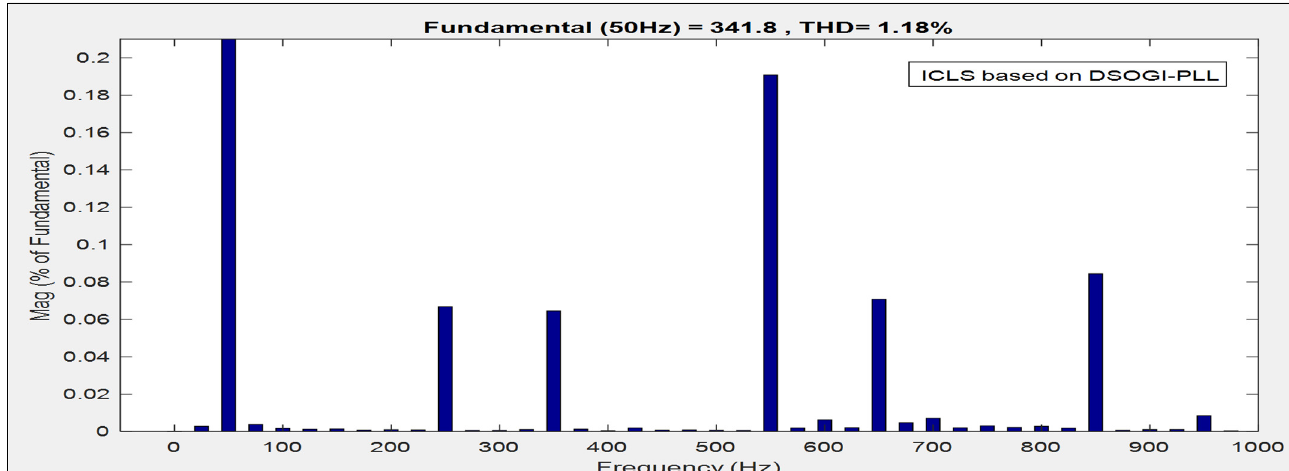
Figure 16. Case study 2 Three-phase grid voltages and current with ICLS-DSOGI-PLL.